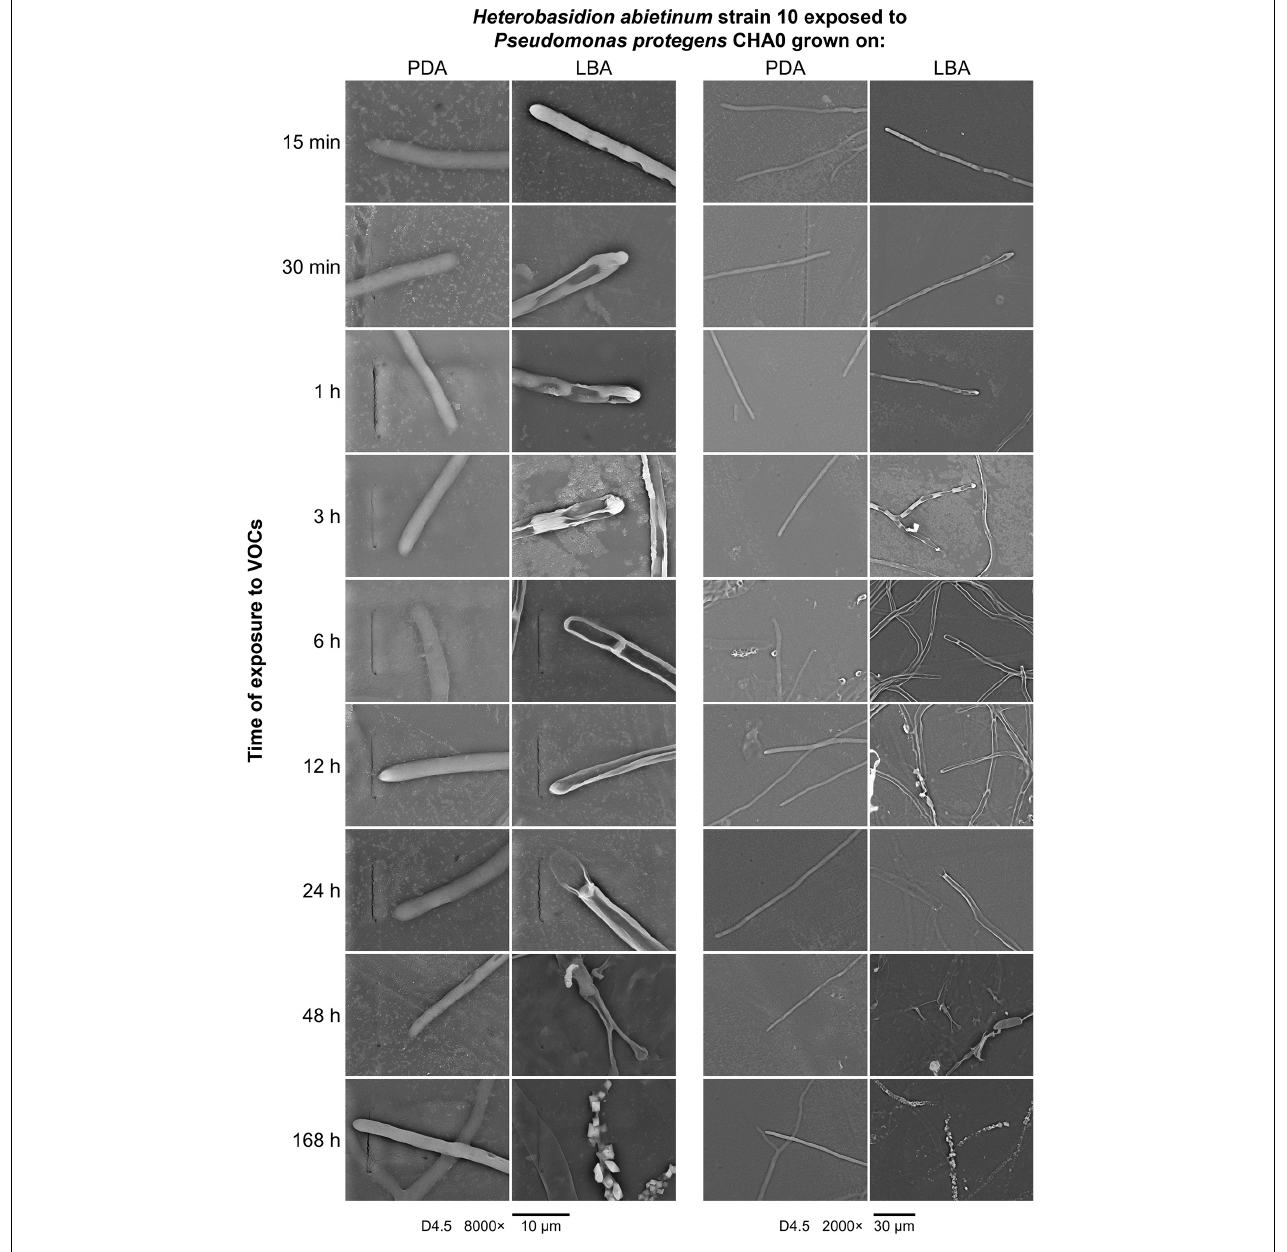
FIGURE 6 | Experiment J. Observations at the scanning electron microscope (SEM) of the effect of volatile organic compounds (VOCs) emitted by Pseudomonas protegens CHA0 when grown on Luria-Bertani agar (LBA) rather than on potato dextrose agar (PDA) against Heterobasidion abietinum strain 10. The photos show hyphal tips of H. abietinum strain 10 damaged by the VOCs emitted from CHA0 grown on